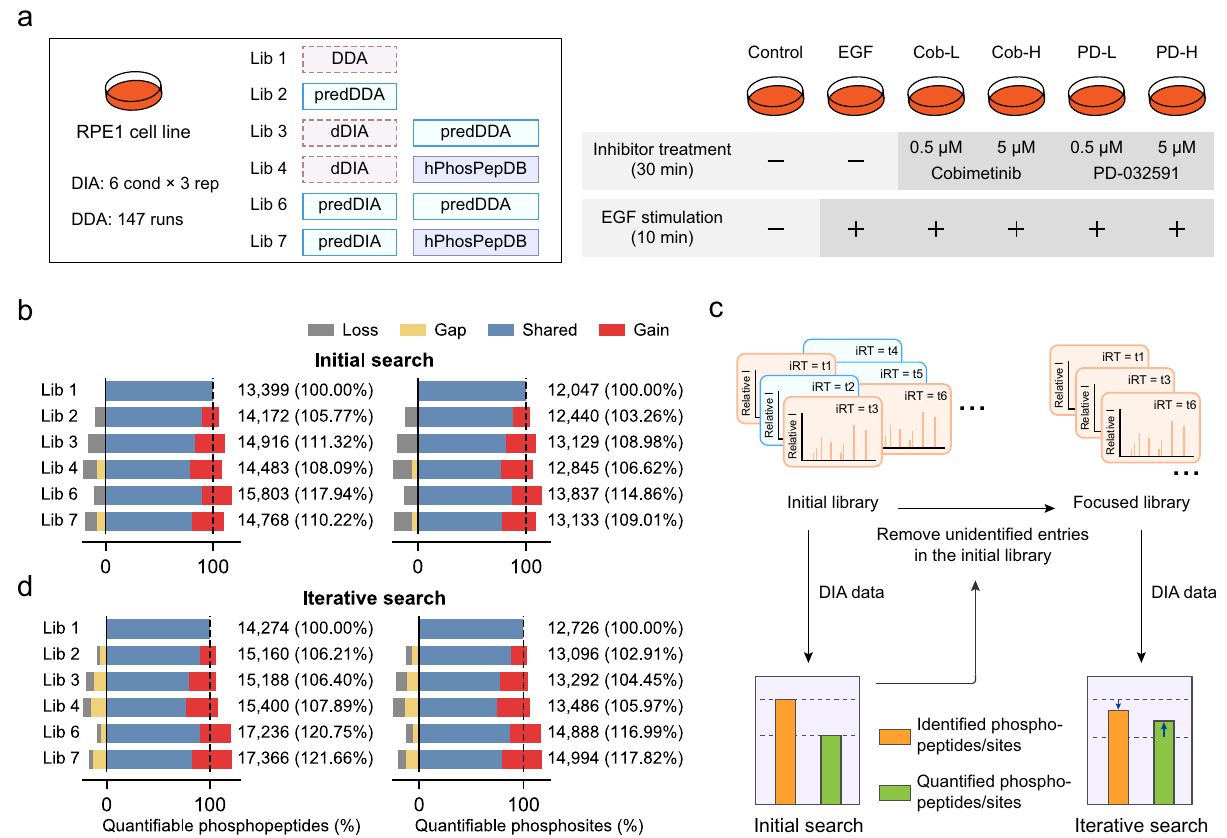
Fig. 4 DIA data analysis with DeepPhospho predicted libraries in a phosphosignaling study. a Design of six spectral libraries as de fi ned in Fig. 3b for the RPE1 DIA data analysis (left) and experimental design of the EGF signaling study in the context of MEK inhibition (right). b Number of phosphopeptides and phosphosites that were quanti fi ed from the initial search using each library. c Procedure of building a focused library to be used for an iterative search. d Number of phosphopeptides and phosphosites that were quanti fi ed from the iterative search using each library. Percentage of the total quanti fi able phosphopeptide or phosphosite number is shown for each predicted library relative to Lib 1. The proportions of shared identi fi cations (IDs), gained IDs, lost IDs, and gap IDs yielded by Lib 2 to Lib 7 compared to Lib 1 are indicated in different color. Source data for this fi gure are provided as a Source data fi estimated to be 0.06-0.89% for initial and iterative searches using Lib 6 or Lib 7 (Supplementary Fig. 7e).